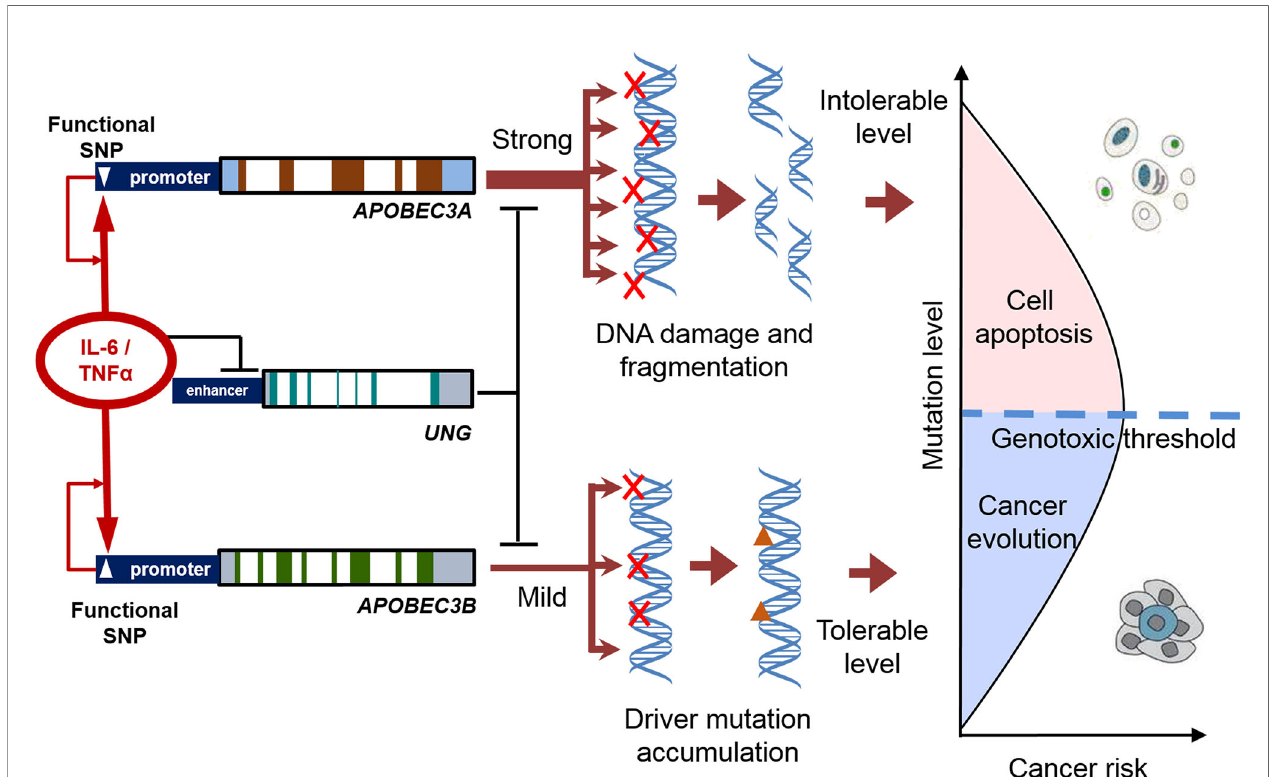
FIGURE 2 | The balance between mutagenic activity and tolerance of cells to genotoxicity in the process of cancer evolution. In fl ammatory factors increase the expression of APOBECs and decreased the expression of UNG. The functional polymorphisms enhance the APOBEC-UNG imbalance and promote the generation of somatic mutation (and viral mutation). A tolerable increase in somatic mutations can improve the diversity of mutant cells. If the mutations exceed the tolerable limit, affected cells undergo apoptosis, instead of developing into cancer-initiating